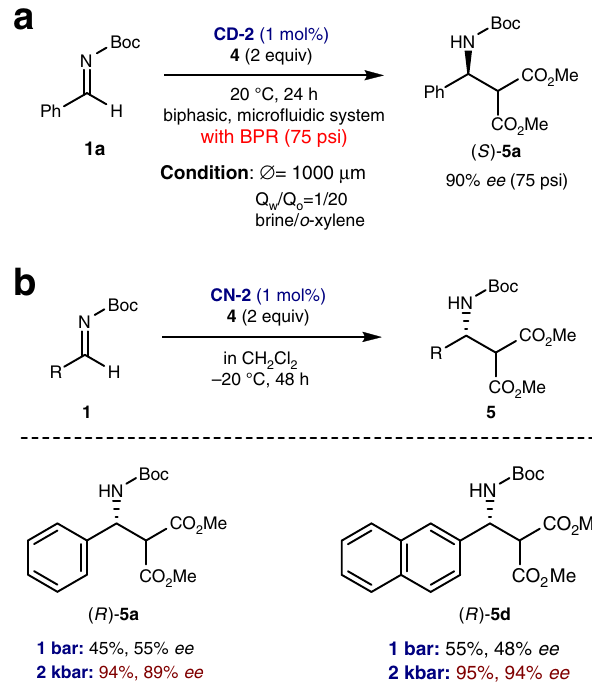
Fig. 4 High pressure experiments. a High pressure effect on enantioselectivity under biphasic micro fl uidic conditions using a BPR (back pressure regulator). † Reaction conditions: 1a (1 equiv), 4 (2 equiv) and CD-2 (0.01 equiv), ø = 1000 μ m, Q an organic solvent. † Reaction conditions: 1a (0.24 mmol), 4 (0.48 mmol) and catalyst (1 mol%) in CH 2 Cl 2 (4.0 mL) at − 20 o C. The melting point of water under 2 kbar is − 20.8 o C